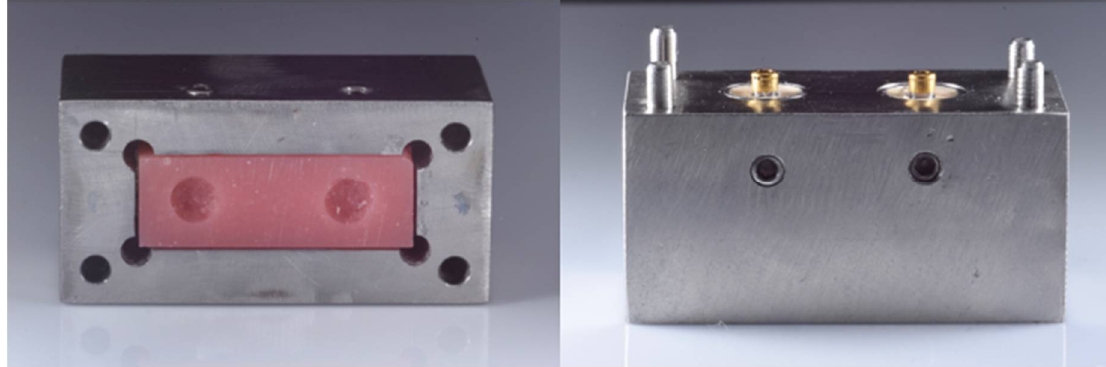
Figure 1. The upper and lower portions of specimens with an acrylic block.